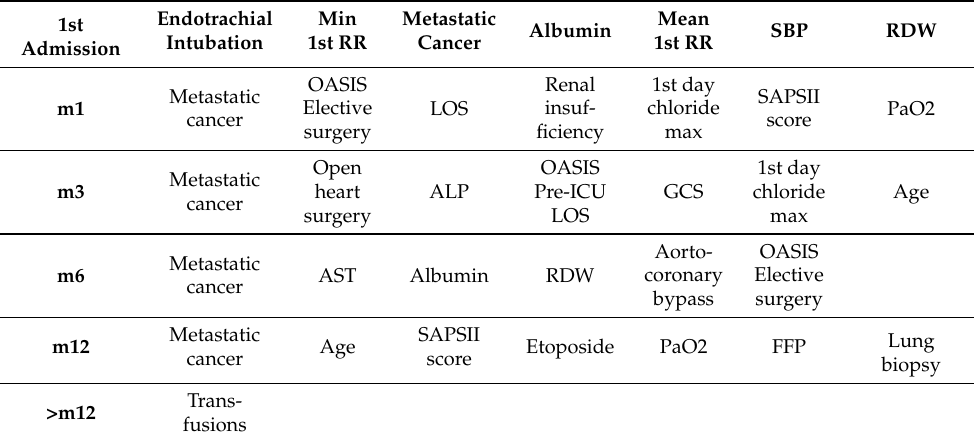
Table A2. Most important selected features with predictive performance for early and late mortality in ICU patients with cancer. (Abbreviations: LOS, length of stay; SBP, systolic blood pressure; RDW, red cell distribution width; RR, respiratory rate; AST, aspartate transaminase; GCS, Glasgow Coma Scale; PaO2, partial pressure of arterial oxygen; FFP, fresh frozen